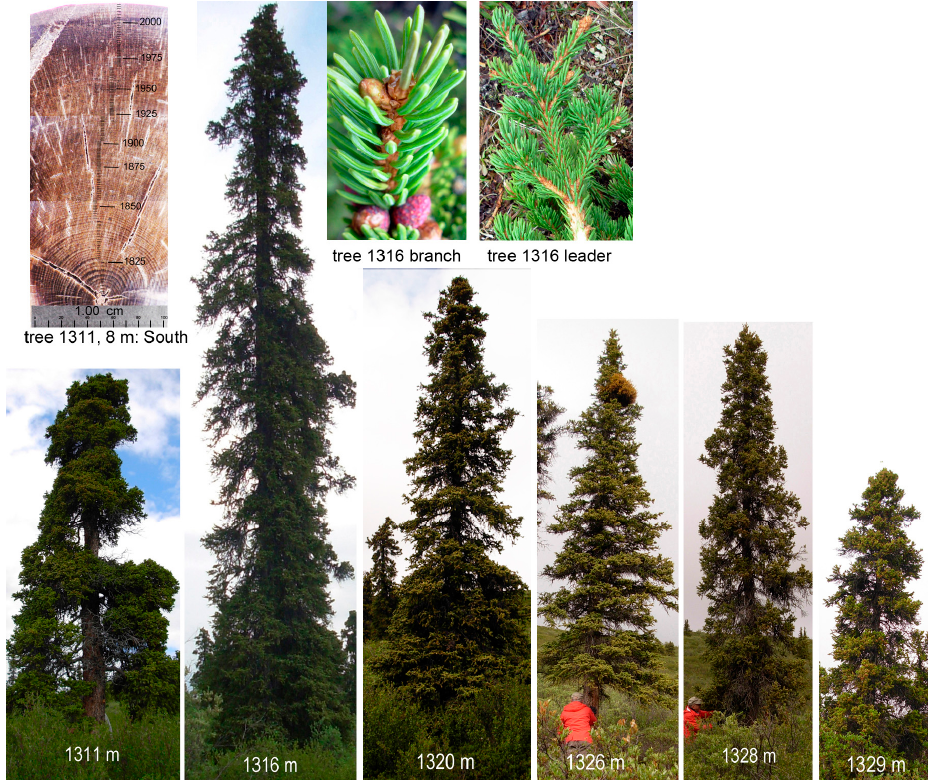
Figure 11. The six investigated trees photographed just before being felled in 2007 (1316 m) and 2008 (the other five trees). The 8 m South radius of tree 1311 in cross section, and the tree top and stage of budbreak of tree 1316 are shown at left and right, respectively, of the top of tree 1316. Altitudes and geographic coordinates of the six (Table 1) were obtained by hand-held gps, using World Geodetic System (WGS-84) coordinates with the Wide Area